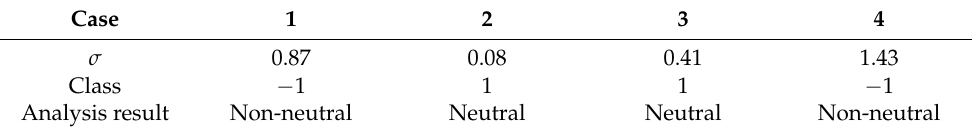
Table 6. Analytical method